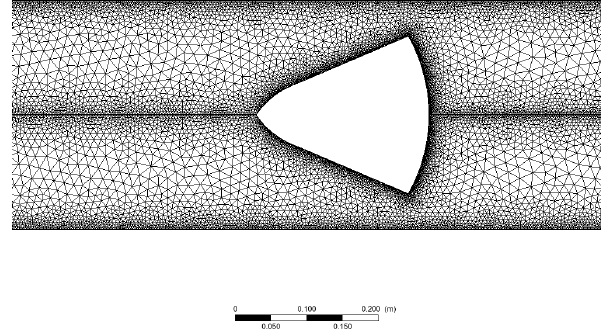
Figure 7. Unstructured mesh for the P-G cone flowmeter.